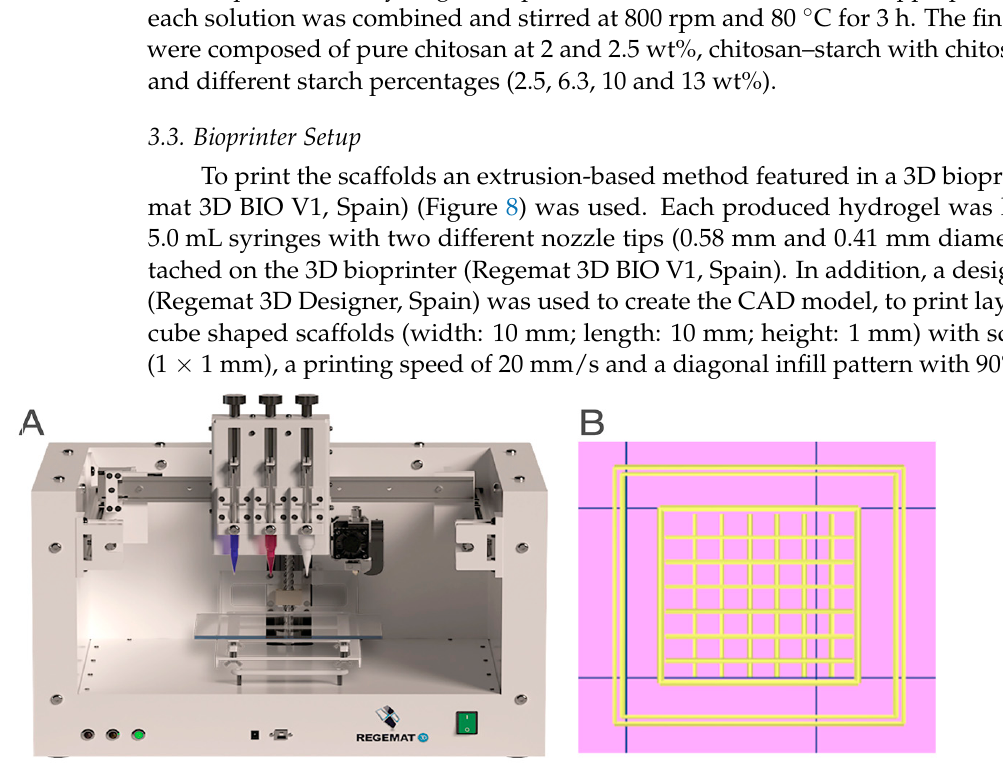
Figure 8. ( A ) Configuration of the Regemat 3D Bioprinter and ( B ) CAD model designed on the Regemat 3D software to print all the scaffolds.